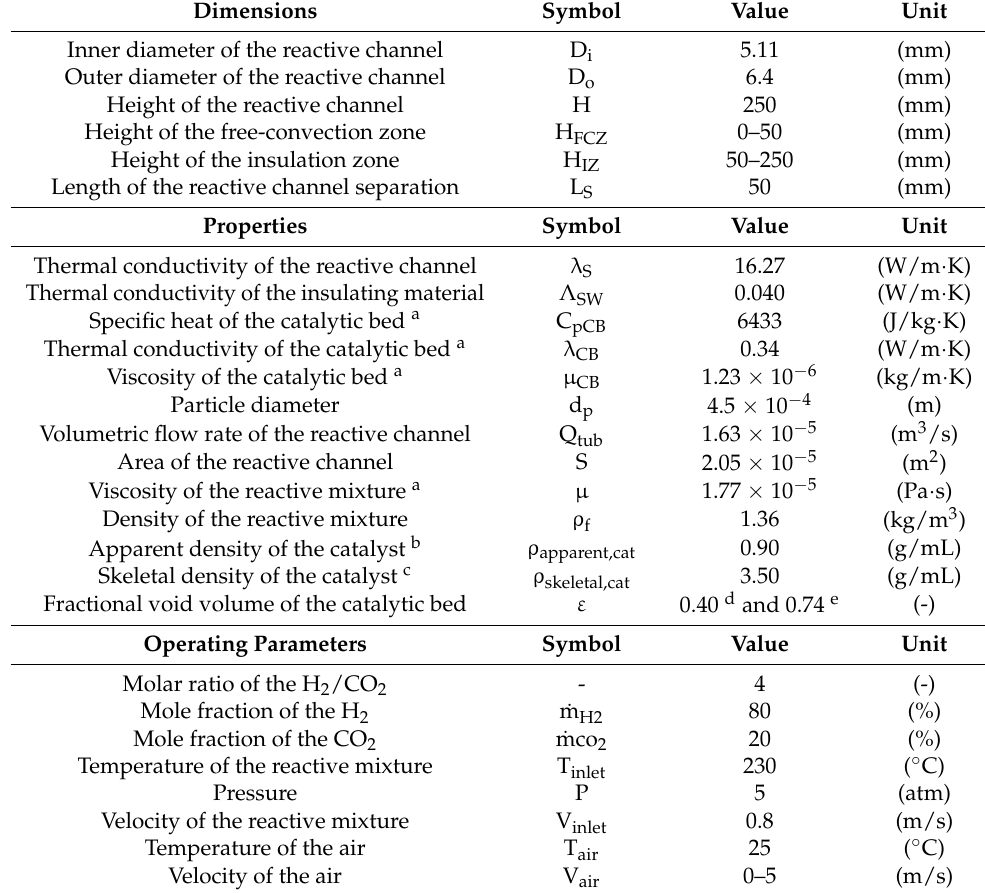
Table 1. Dimensions, thermophysical properties, and operating parameters used in the simulation of a multi-tubular fixed-bed reactor with circular-shaped distribution for CO 2 methanation